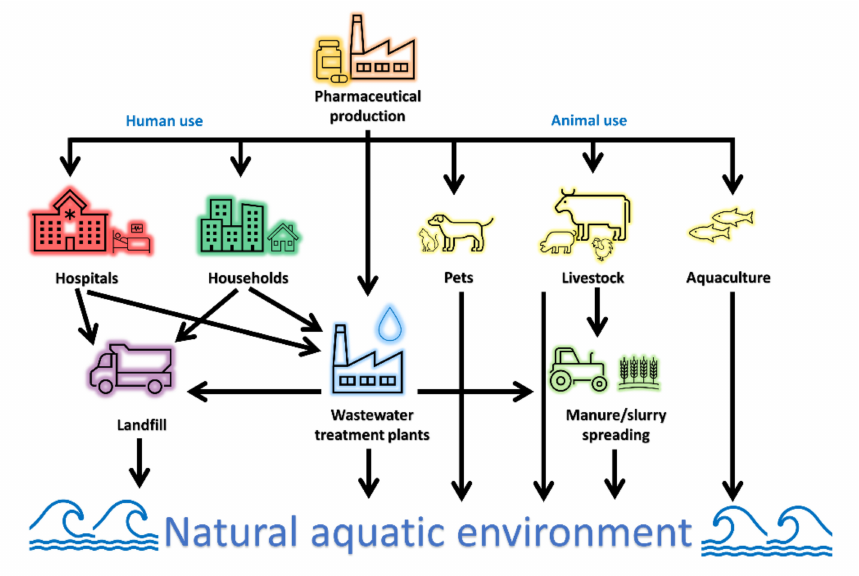
Figure 4. Pathways of antibiotics release into the